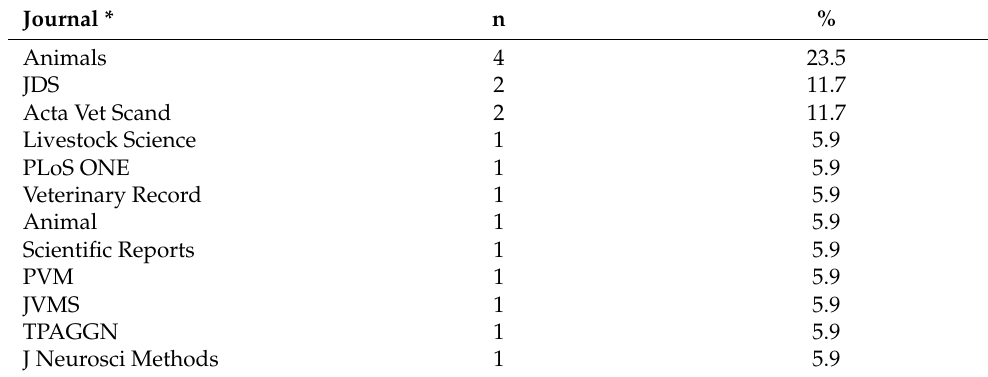
Table 3. Number and percentage of publications by name of the peer-reviewed journal.